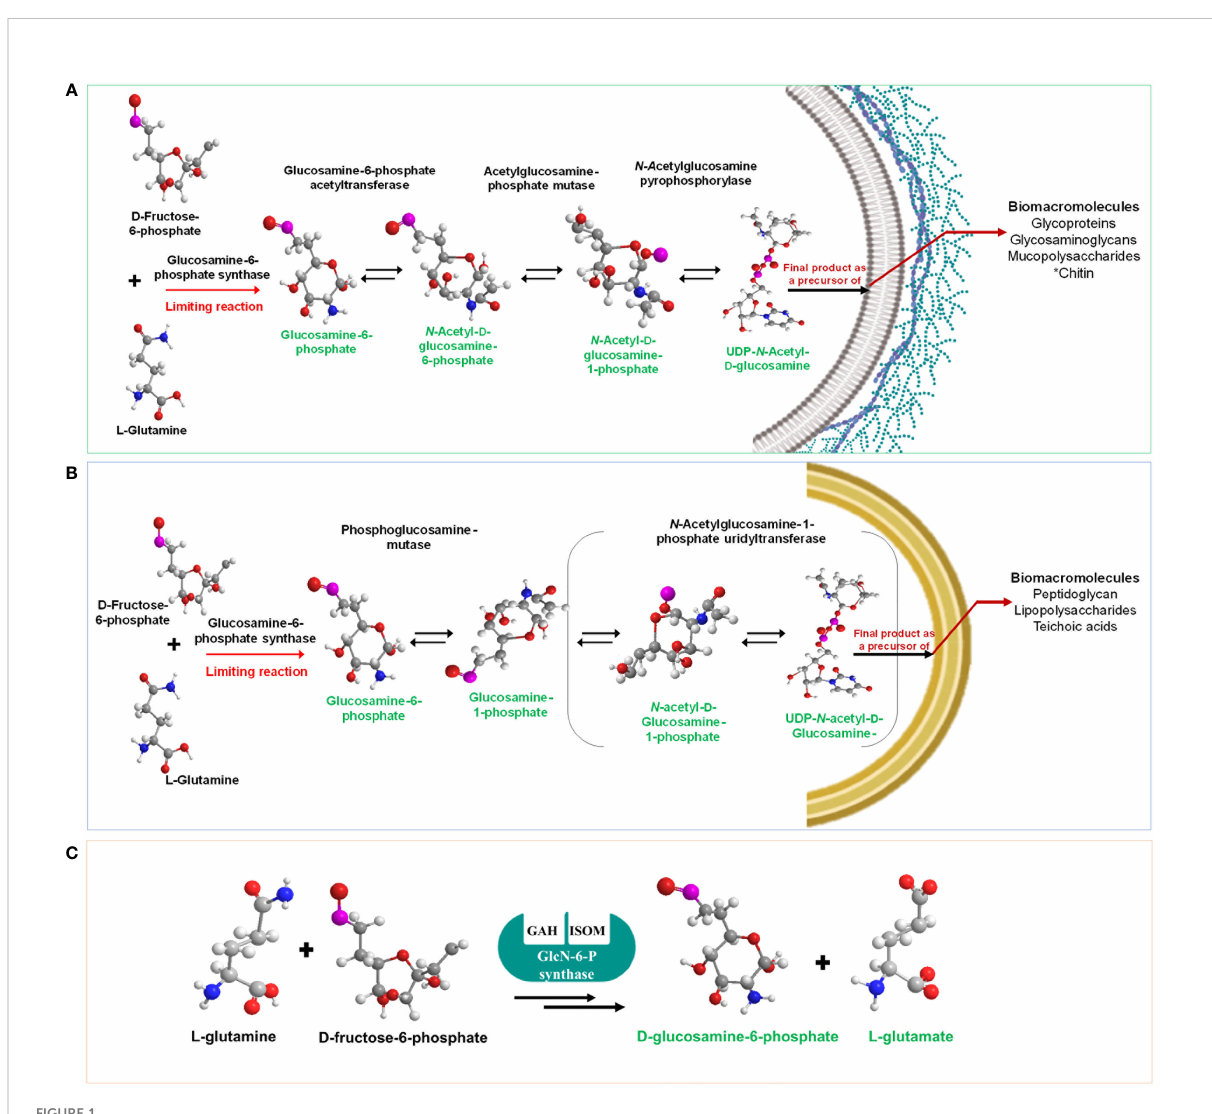
FIGURE 1 HBP in eukaryotes (A) and prokaryotes (B) . Notice that in prokaryotes, the pathway consists of only three enzyme reactions and that in both organisms GlcN-6-P synthase limits the production of UDP-N-acetylglucosamine, a precursor of a plethora of biomacromolecules in a great diversity of organisms. The reaction catalyzed by GlcN-6-P synthase is shown in (C) where the active centers of the enzyme are indicated. GAH, glutamine amidehydrolysing; ISOM, hexose